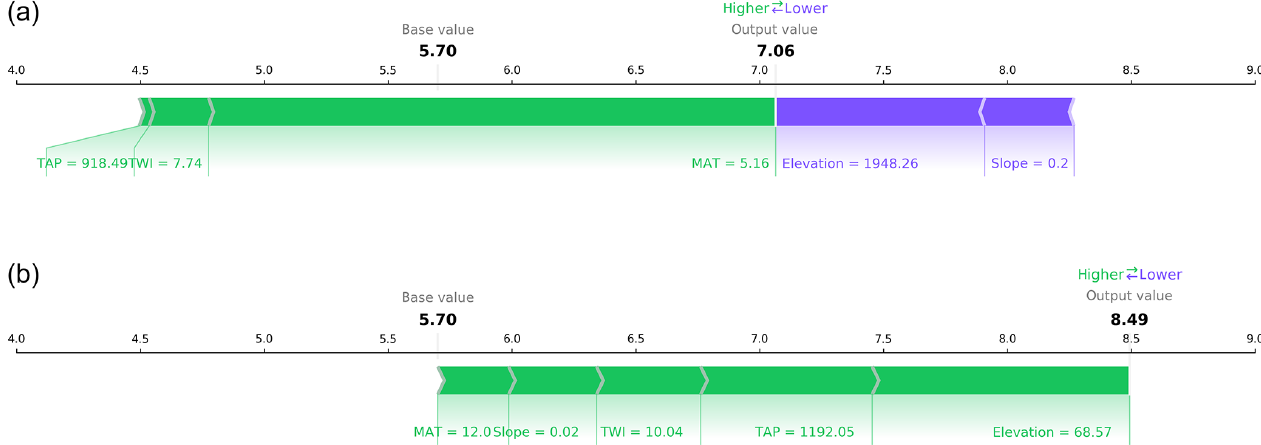
Figure 3. Force plots of the same two samples presented in Fig. 2. The figures depict the positive (green) and negative (purple) aggregated contributions that deviate the SOC content from the expected base SOC value (the mean of the predictions for the complete dataset; 5.7% in this case). The sum of all the contributions plus the base value yield the model output (7.06% and 8.49% for panels a and b , respectively.)